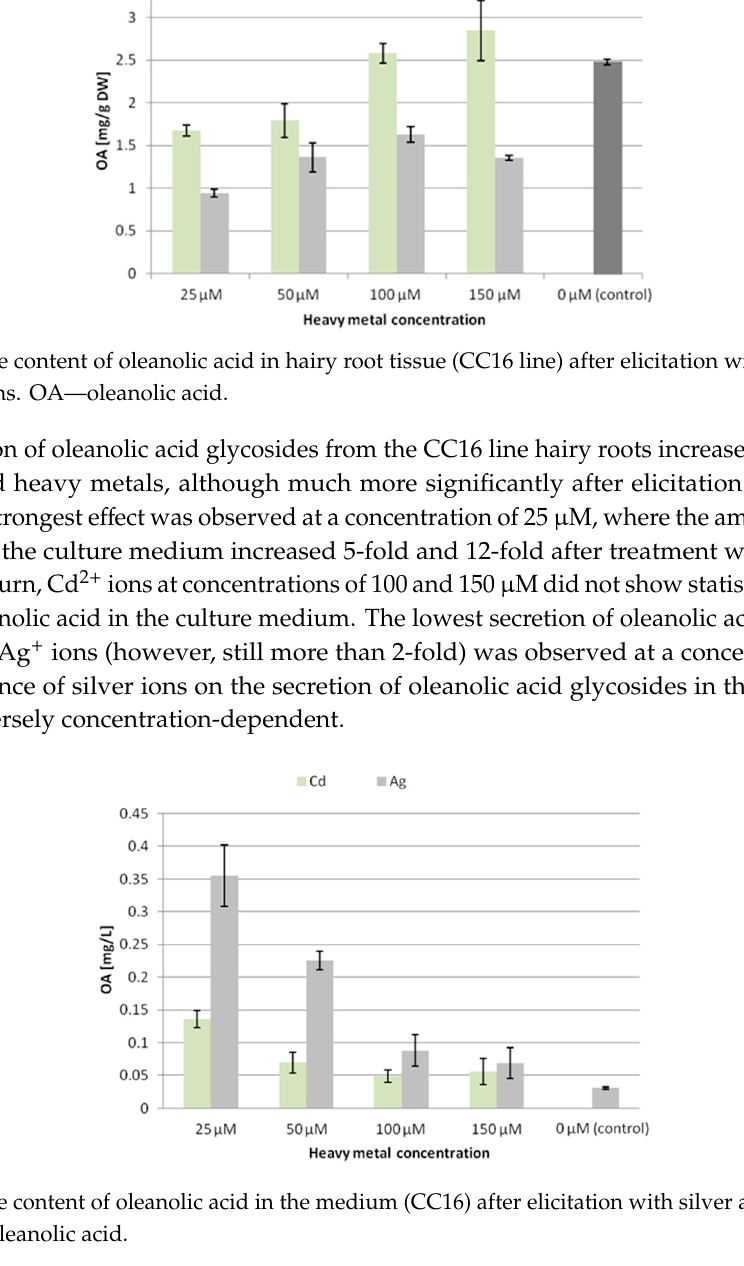
Figure 3. The content of oleanolic acid in the medium (CC16) after elicitation with silver and cadmium ions. OA—oleanolic acid.